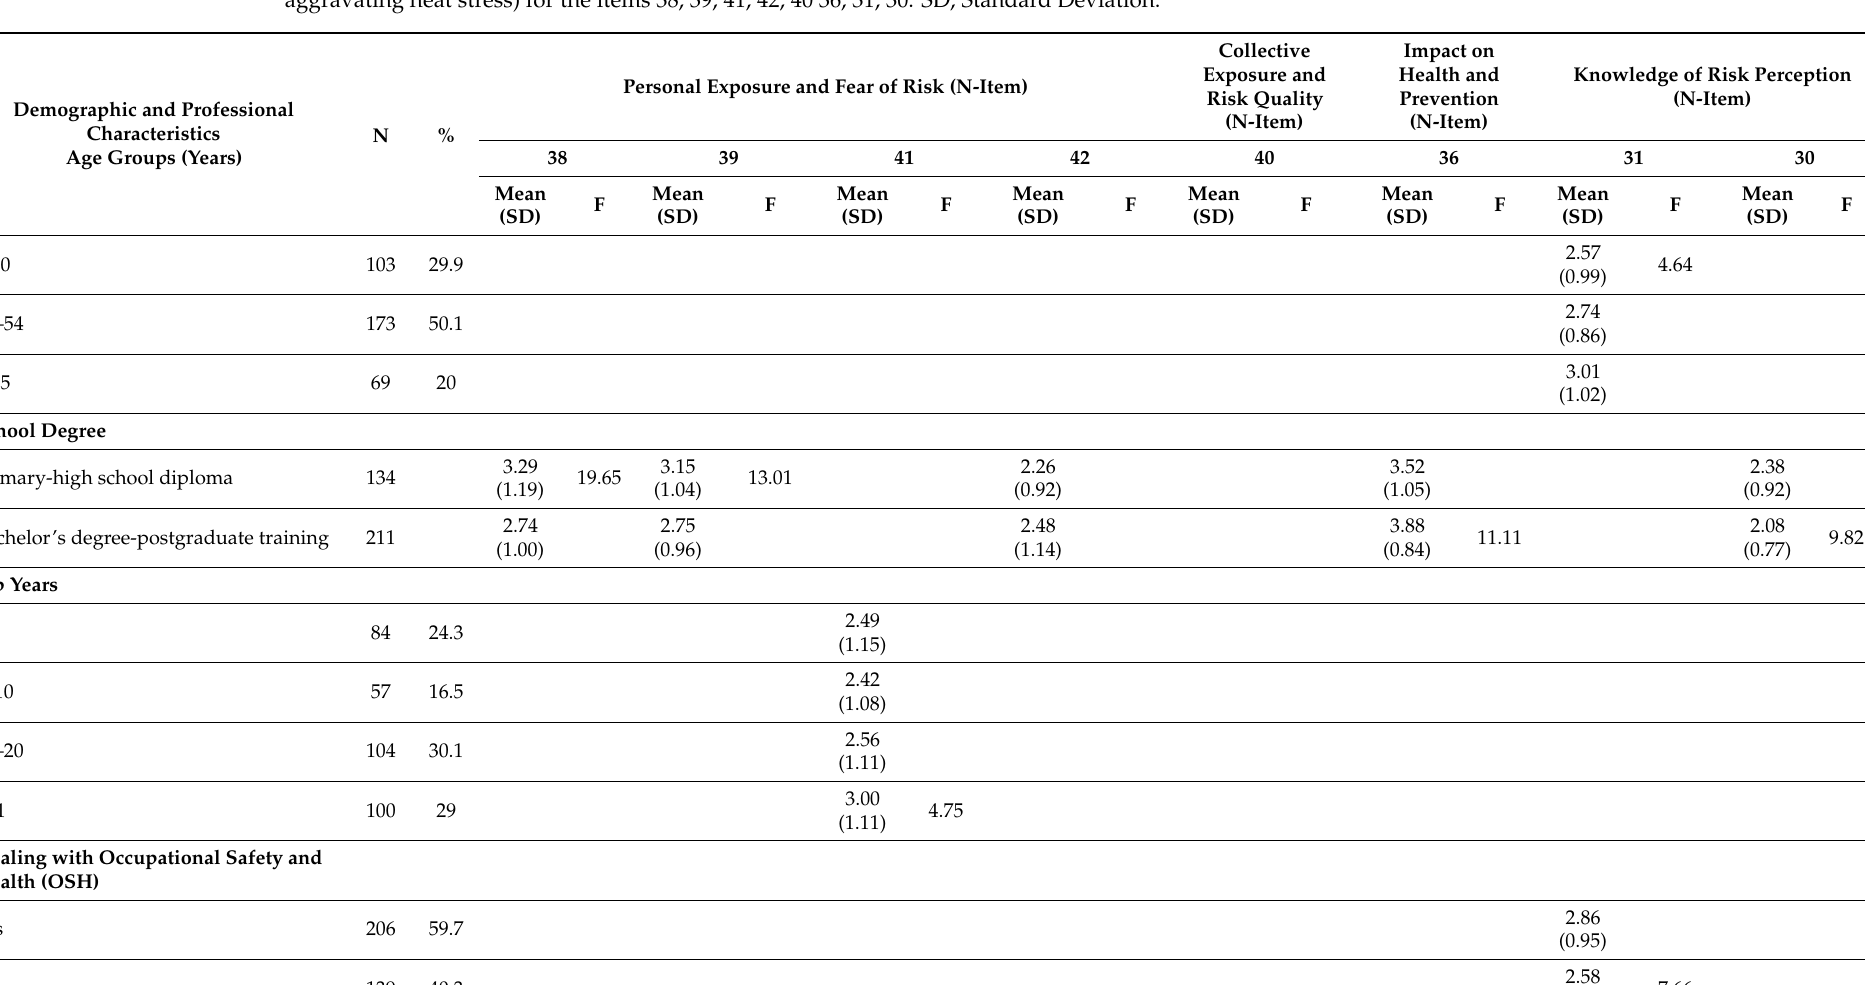
Table 5. Personal exposure and fear of risk for three macro-groups (a demographic and professional characteristics, b characteristics of the work, c